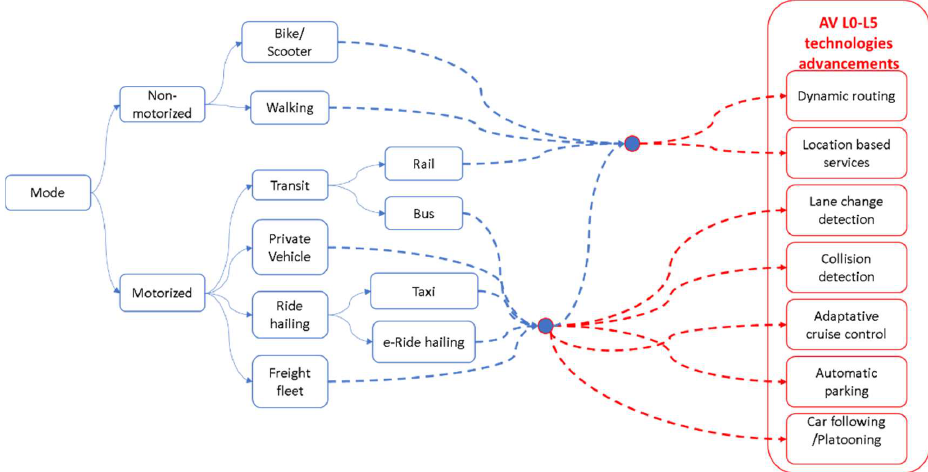
Figure 9. Graph of partial STS components and application areas.